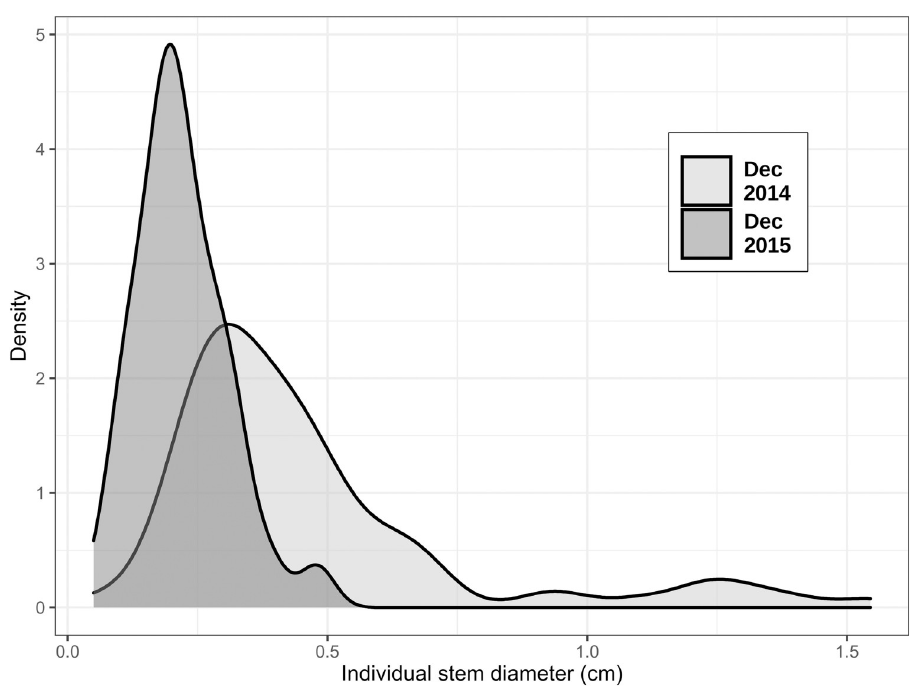
Fig 1. Change in the population structure of Forsteronia glabrescens population one year after being submitted to stem harvesting.